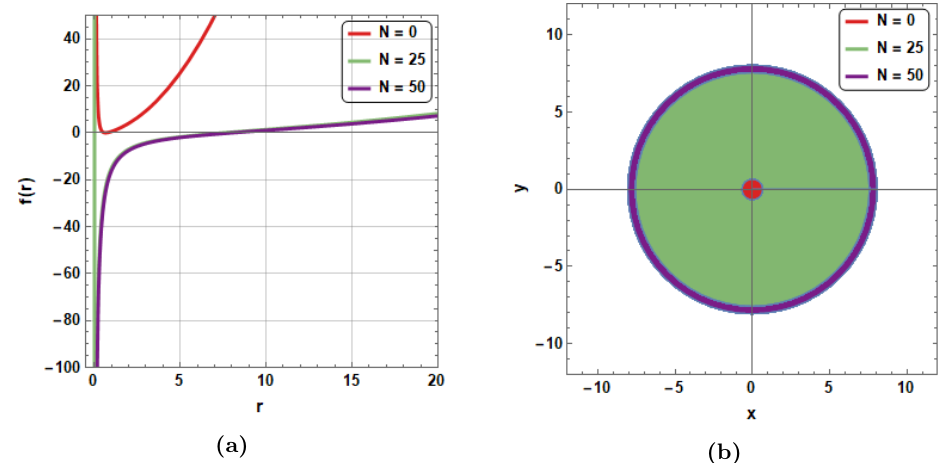
Figure 17. (a): evolution of f ( r ) function during an isentropic neutralization of an extremal black hole with the absorption of 10 5 over 50 periods. (b): evolution of black hole projection on xy plan during an isentropic neutralization of an extremal black hole with an absorption of 10 5 over 50 periods. The initial conditions are Q = 1 , l = 1 , M = 1 . 23 , r h = 0 . 65 and D = 4